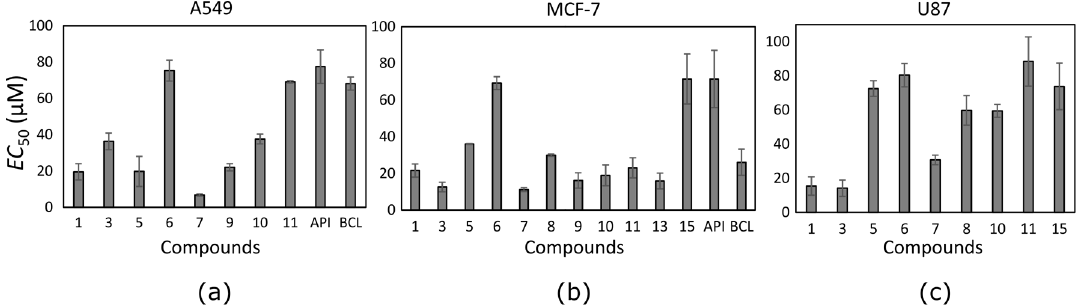
Figure 3. The EC 50 values of the most active trihydroxyflavones against ( a ) A549, ( b ) MCF-7, and ( c ) U87 cancer cell lines.